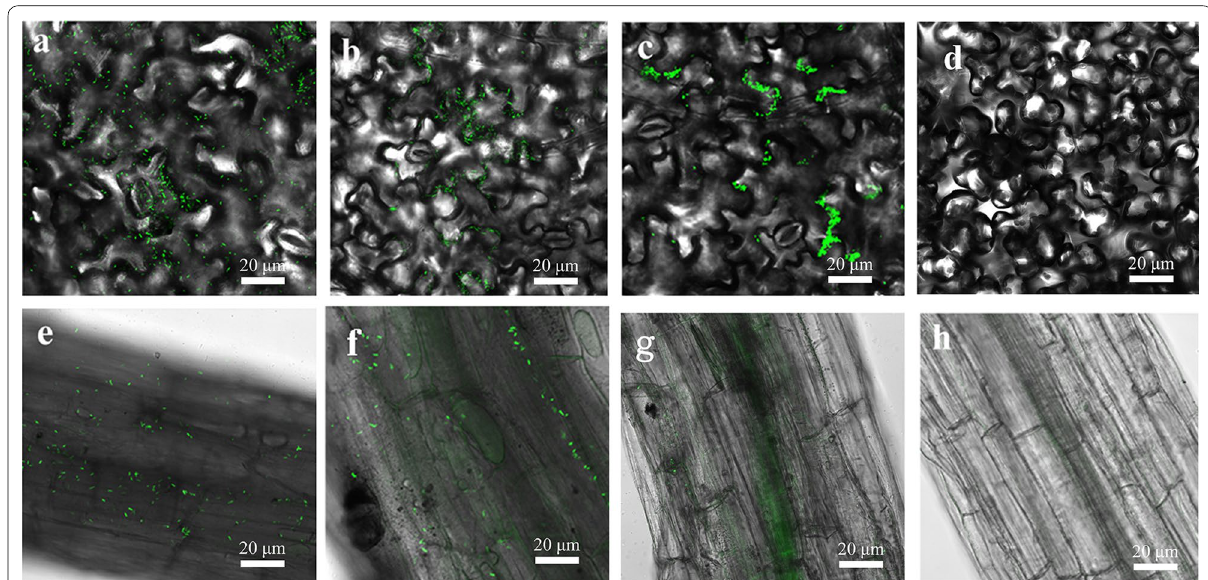
Fig. 4 CLSM images of colonization of strain GJ-22-gfp on the leaves and root of tobacco. a – c and e – g were the results of foliar and root treatment for 24 h, 48 h and 72 h respectively. a Large numbers of fluorescence strains were observed on the surface of leaf without orderliness; b numerous of bacterial cells were adhered on the epidermal cell groove of tobacco leaves; c single cells formed aggregates were colonized the intercellular spaces; e numerous fluorescence cells were observed on the surfaces of primary roots; f long strings of green fluorescent cells were observed along the root epidermal cells; g single GJ-22-gfp cells were observed on root surface and occupied longitudinal intercellular spaces of roots surface. No cells were found in blank control leaf d and root h of tobacco. Magnification, 20. And the experiment was repeated seven times ×